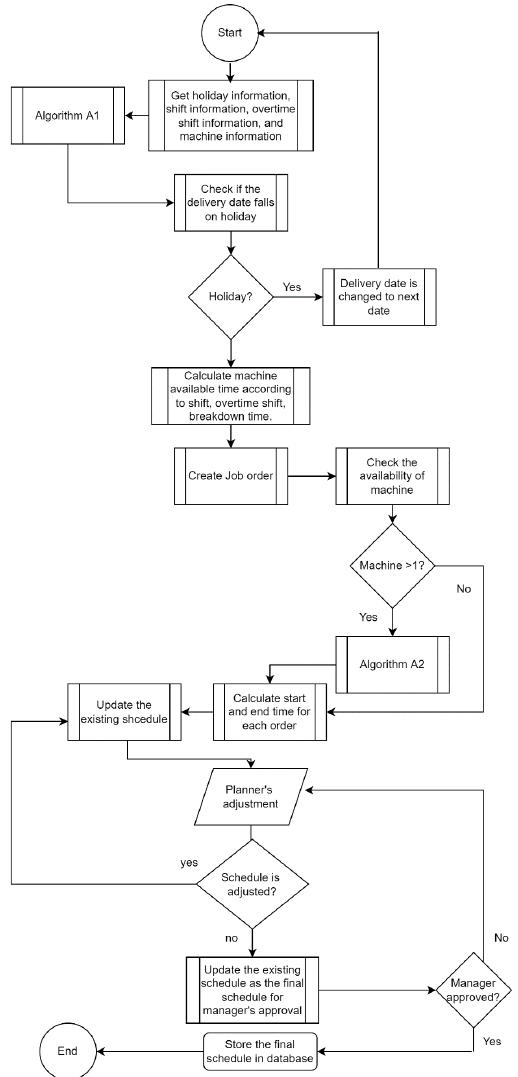
Figure A1. Scheduling algorithm flow chart.